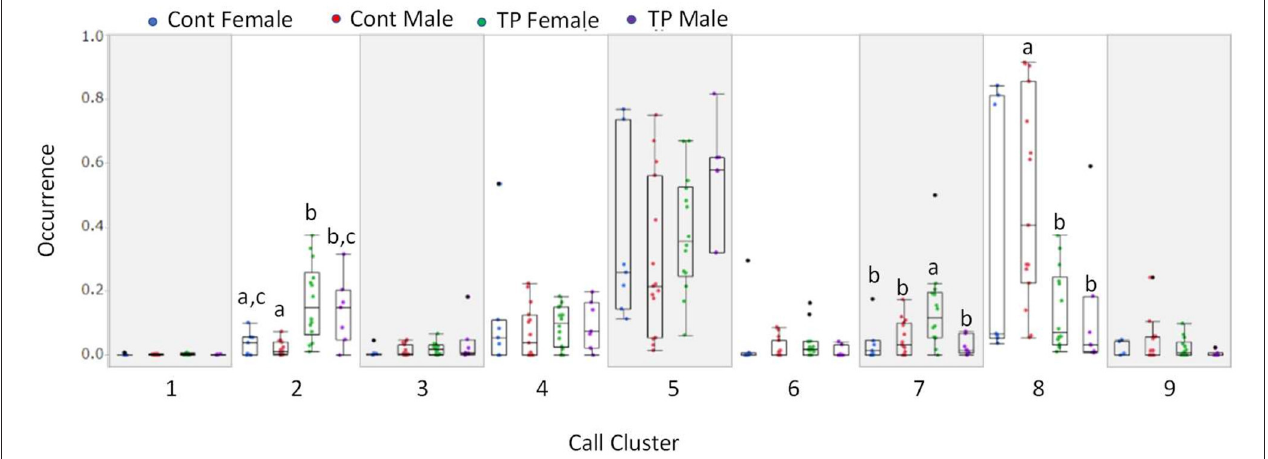
FIGURE 4 | The probability of occurrence of 9 call types. The Y axis represents the probability of the occurrence of each call. Call types 2, 7, and 8 showed group differences.